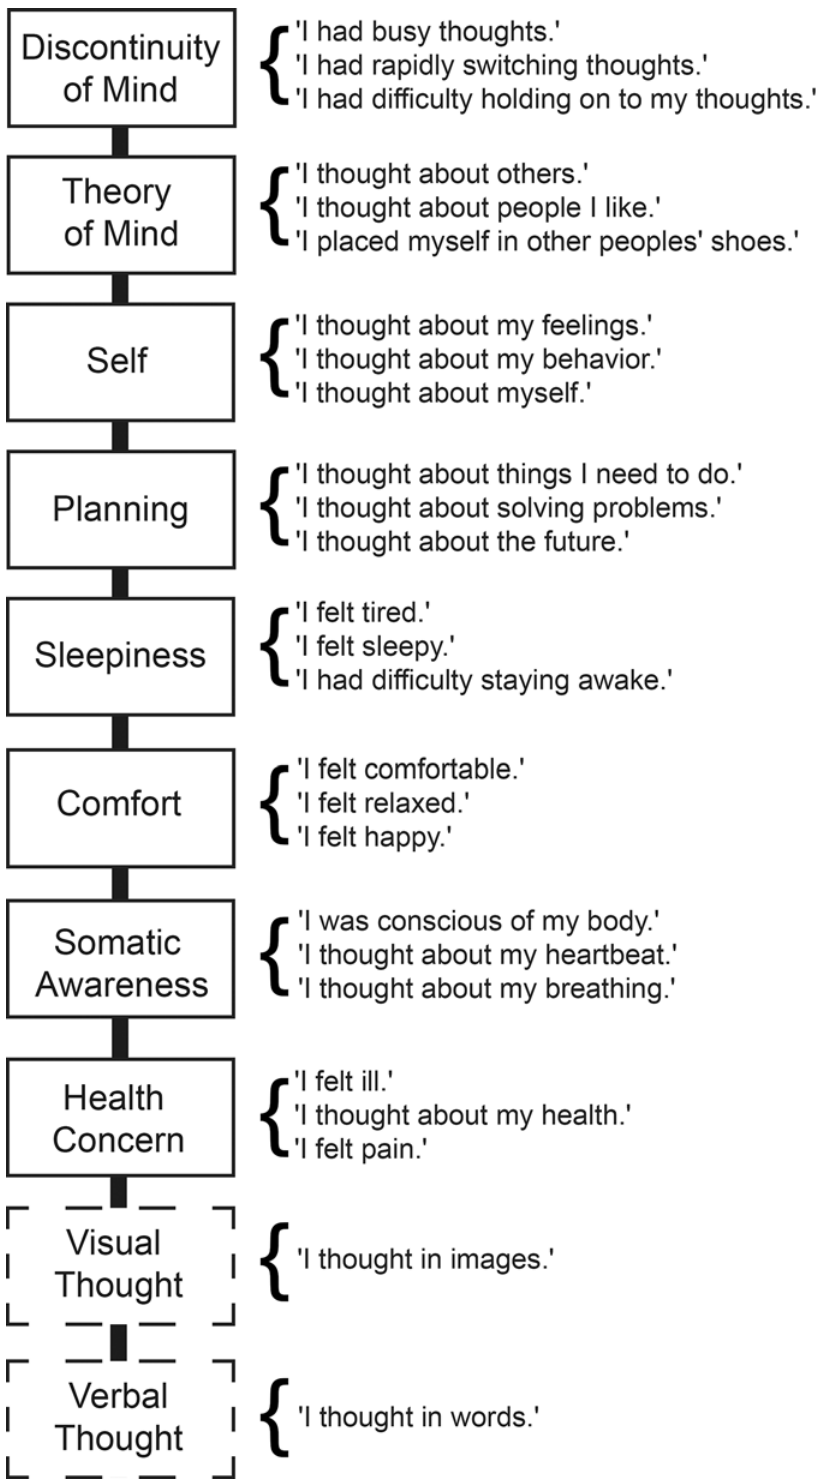
Fig 1. A resting-state experience can be partitioned into multiple dimensions. The different dimensions of the resting-state mind-wandering experience as probed by the Amsterdam Resting-State Questionnaire are shown in black boxes. Dimensions sampled by single items are shown in dashed boxes, items used to model each of these dimensions are shown to the right of each box.